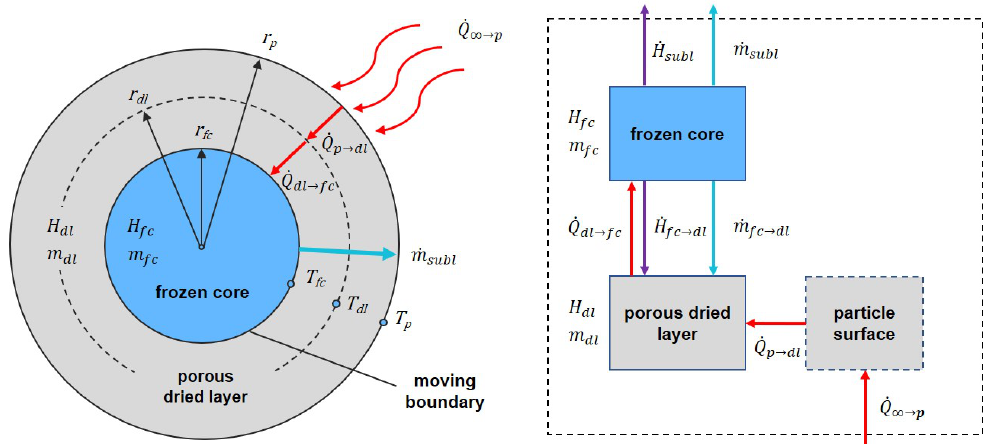
Figure 1. Model structure for the freeze-drying process of a single particle using a shrinking core approach. The different model regions, i.e. frozen core, porous dried layer and particle surface, are shown on the left hand side. The image on the right hand side shows the different transfer flows between the model